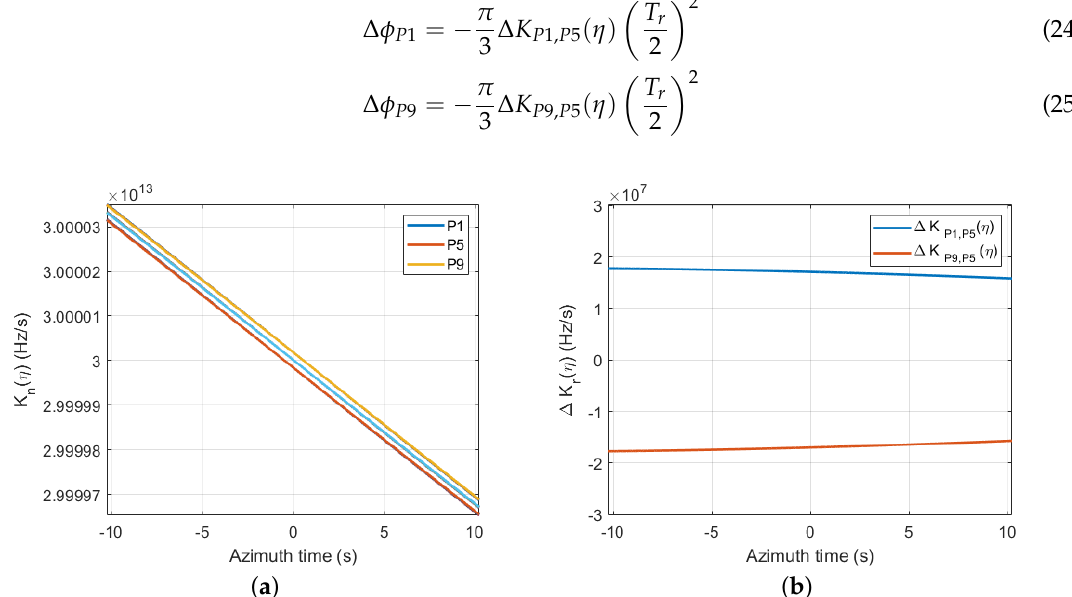
Figure 5. ( a ) The azimuth-time varying K n ( η ) of targets P1, P5 and P9. ( b ) ∆ K P 1, P 5 ( η ) and ∆ K P 9, P 5 ( η ) versus azimuth